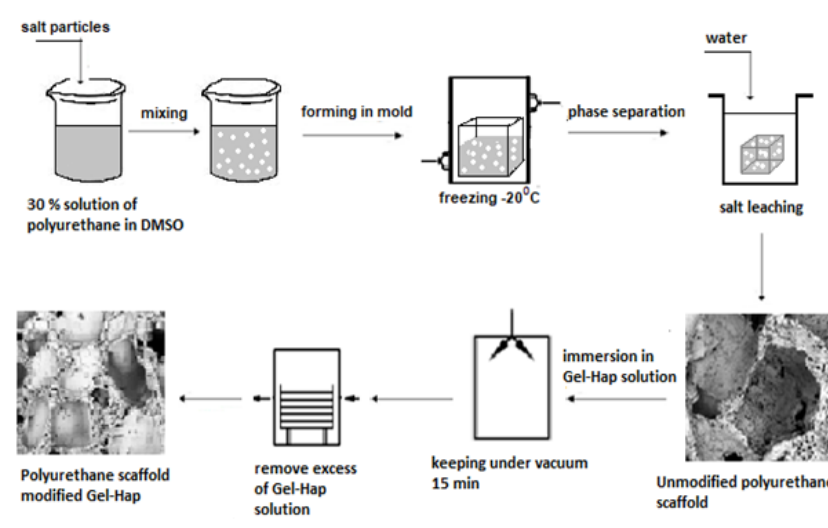
Figure 1. Fabrication process of scaffolds. Table 1. Symbols and descriptions of obtained scaffolds. HAp: hydroxyapatite, PUR: polyurethane.